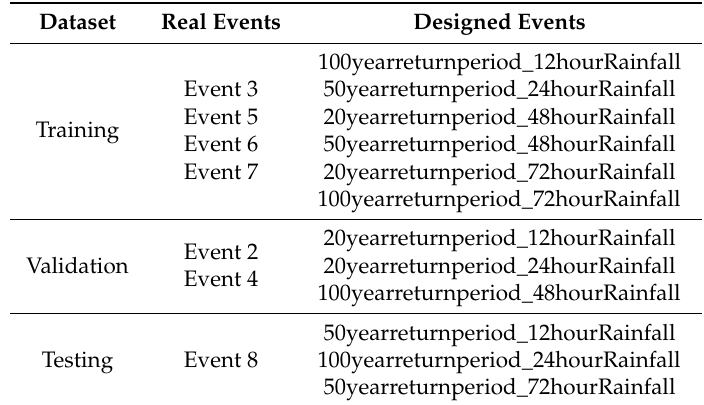
Table 2. Dataset allocation for constructing RNARX models.